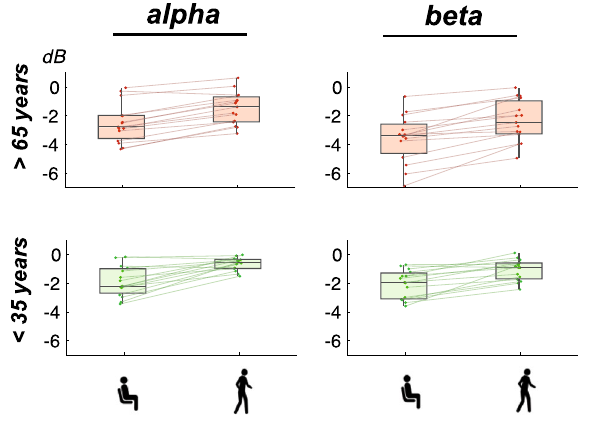
Figure 5. Distribution of button-press related alpha desynchronization values (left column) and beta desynchronization values (right column) in dB in older participants (upper row, in red) and in younger participants (lower row, in green). Scatter points indicate individual mean values for each participant. Within each plot, the means of each participants during sitting and walking are connected by